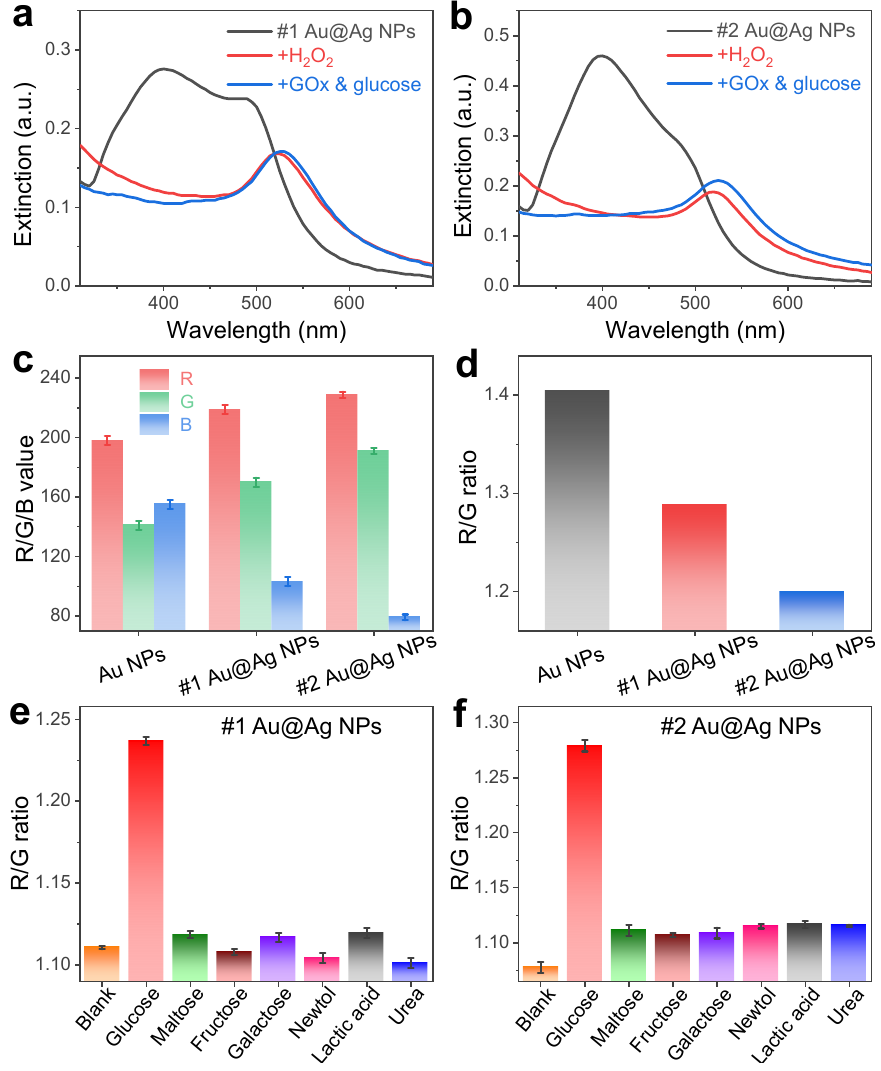
Figure 2. Colorimetric sensing of glucose. ( a , b ) UV-Vis extinction spectra of the pristine ( a ) #1 and ( b ) #2 Au@Ag NPs and the spectra after adding 20 µ L of 5 mM H 2 O 2 (red curve) and 5 mM glucose (blue curve) solutions, respectively. In case of glucose sensing, 20 µ L of 1 mg mL − 1 GOx was also added before adding glucose. ( c ) The R, G, and B values of the photographs of the Au NPs and the #1 and #2 Au@Ag NPs samples. ( d ) The R/G ratios of the photographs of the Au NPs and the #1 and #2 Au@Ag NPs. ( e , f ) The R/G ratios of the photographs of ( e ) #1 and ( f ) #2 Au@Ag NPs samples after sensing of various analytes. A high sensing specificity toward glucose was